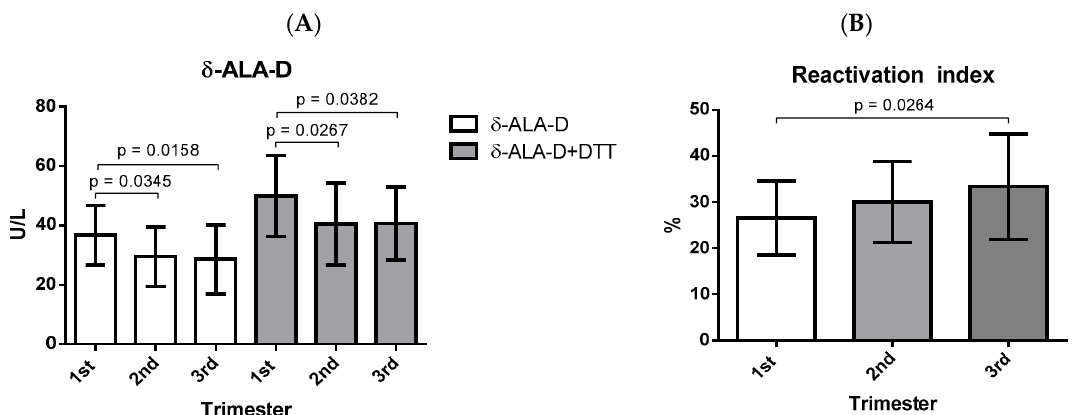
Figure 4. δ -ALA-D activity and reactivation index of the δ -ALA-D enzyme in the three gestational trimesters. The data were determined by ANOVA followed by Tukey’s test and represented as mean with standard deviation. ( A ) δ -ALA-D activity; ( B ) reactivation index of δ -ALA-D enzyme; δ -ALA-D: delta-aminolevulinate dehydratase enzyme; DTT: dithiothreitol.